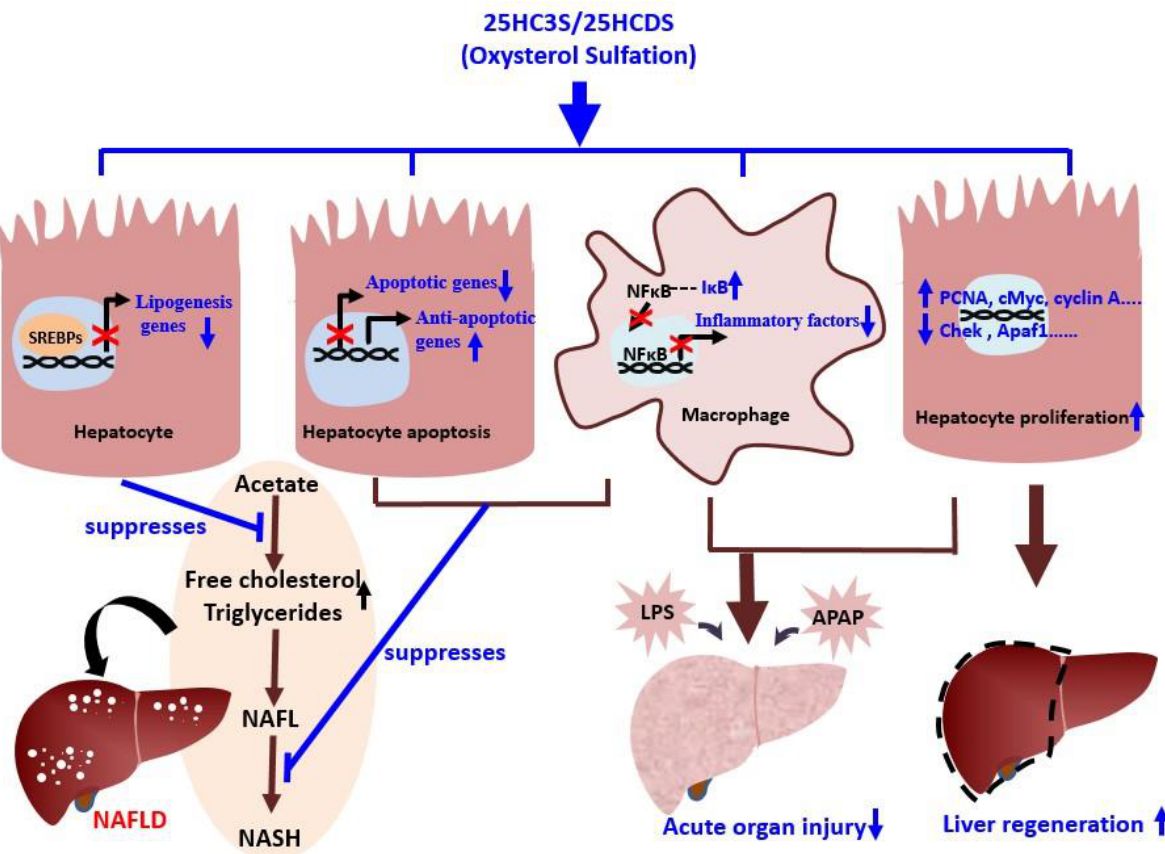
Figure 3. Schematic diagram of the role of oxysterol sulfation in nonalcoholic fatty liver diseases (NAFLD), acute organ injury, and liver